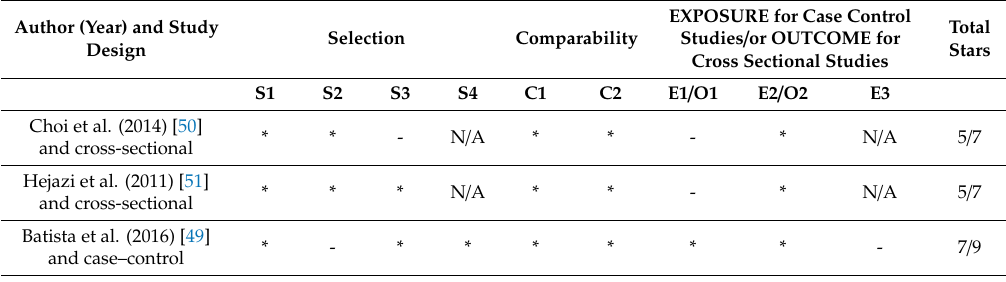
Table 4. Risk of bias assessment of case–control and cross-sectional